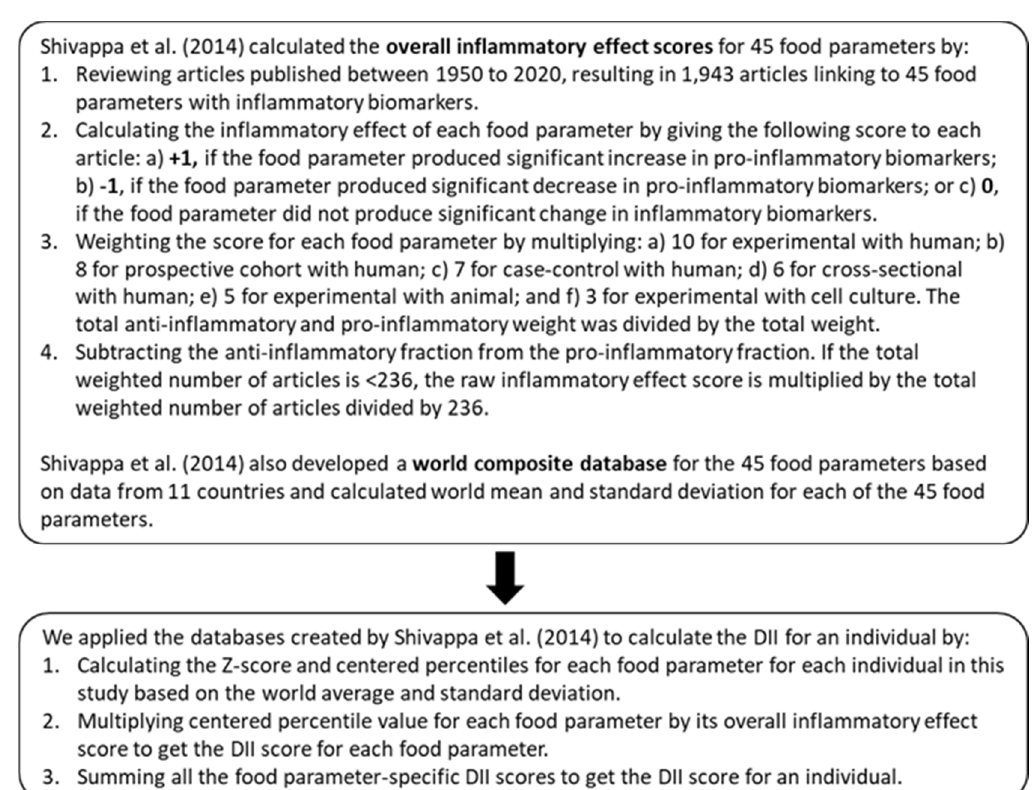
Figure 1. Overview of steps involved in the calculation of the energy-adjusted Dietary Inflammatory Index (E-DII) scores.